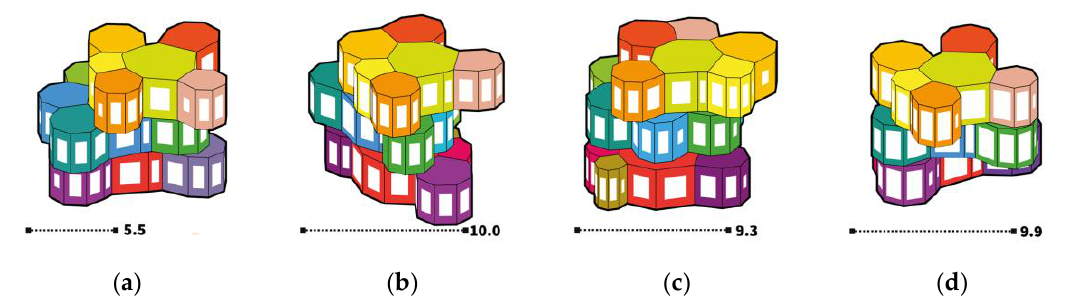
Figure 4. The energy balance result. Each solution matches a score: ( a ) First case with a score of 5.5; ( b ) T First case with a score of 10; ( c ) First case with a score of 9.3; ( d ) First case with a score of